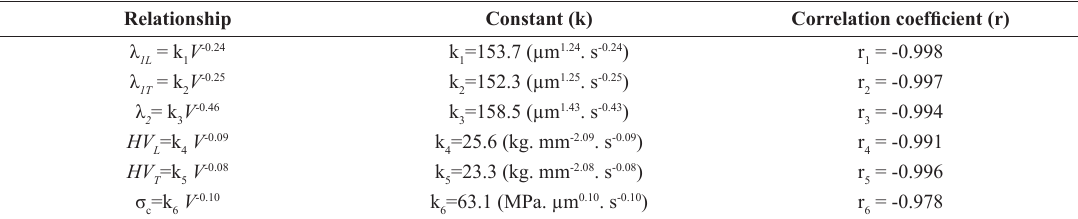
, λ ), mechanical properties ( HV , HV , σ ) and the growth velocity ( V ) 1 2 L T c